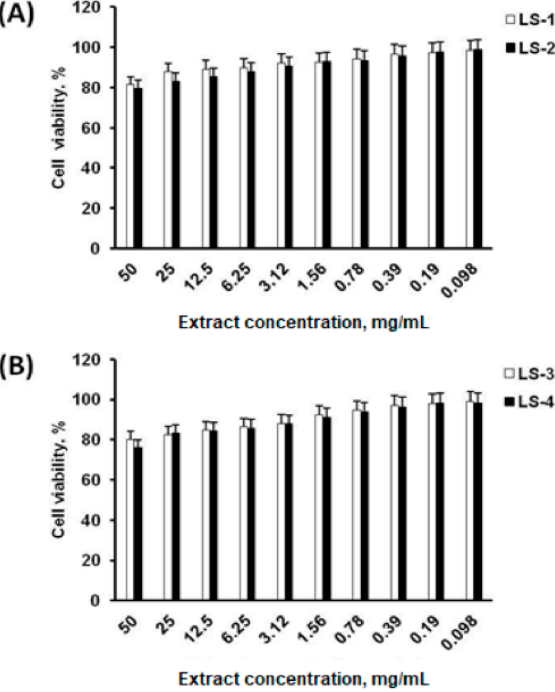
Figure 5. Effects of S. deserta Schang. ( A ) and S. sclarea L. ( B ) extracts on cell viability of neonatal human dermal fibroblasts. (LS-1, LS-3) sage extracts obtained by conventional extraction and (LS-2, LS-4) ultrasonic-assisted extraction.